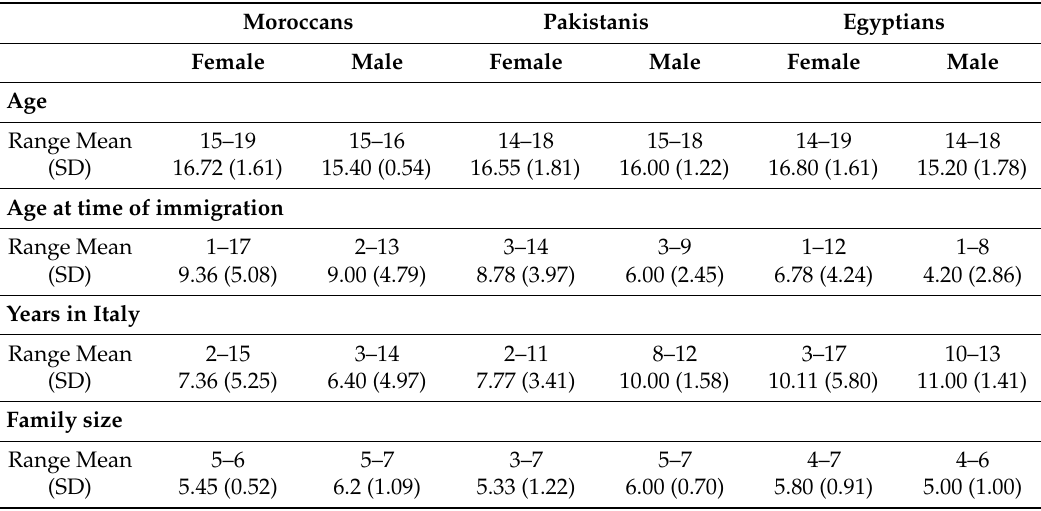
Table 1. Participants’ demographic